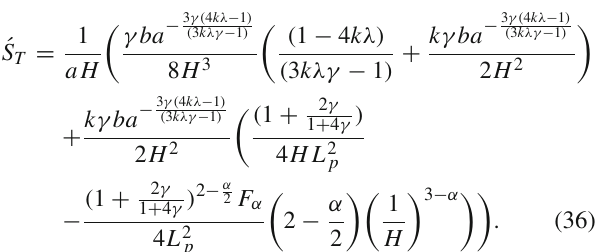
Figure 9 is showing the graph of S α = 1respectively.Thegraphindicatesthethermodynamical equilibrium as the plots are negative for all the values of γ